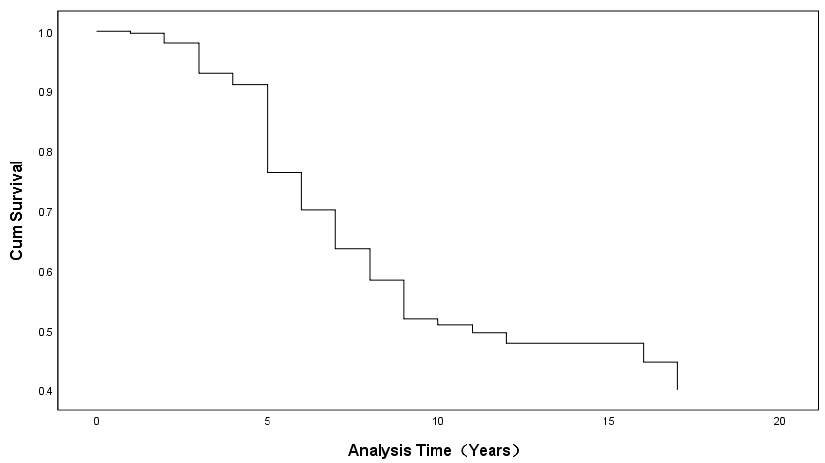
Figure 2. Survival Functions for the Mean of the Covariates (Associate to Full Professor).